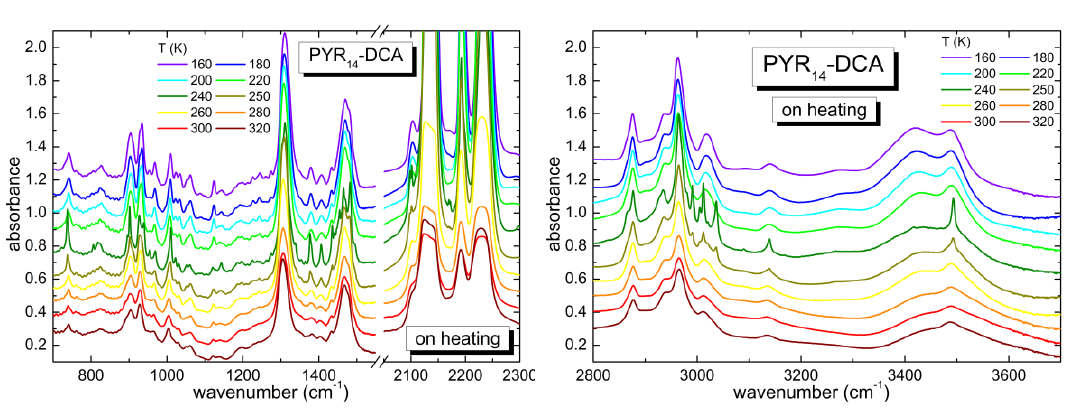
Figure 4. Temperature dependence of the spectra of PYR 14 -DCA measured on heating from 160 up to 320 K in different frequency regions (700–1550 and 2050–2300 cm −1 in the left panel and 2800–3700 320 K in di ff erent frequency regions (700–1550 and 2050–2300 cm − 1 in the left panel and 2800–3700 cm − 1 cm −1 in the right panel). in the right panel).